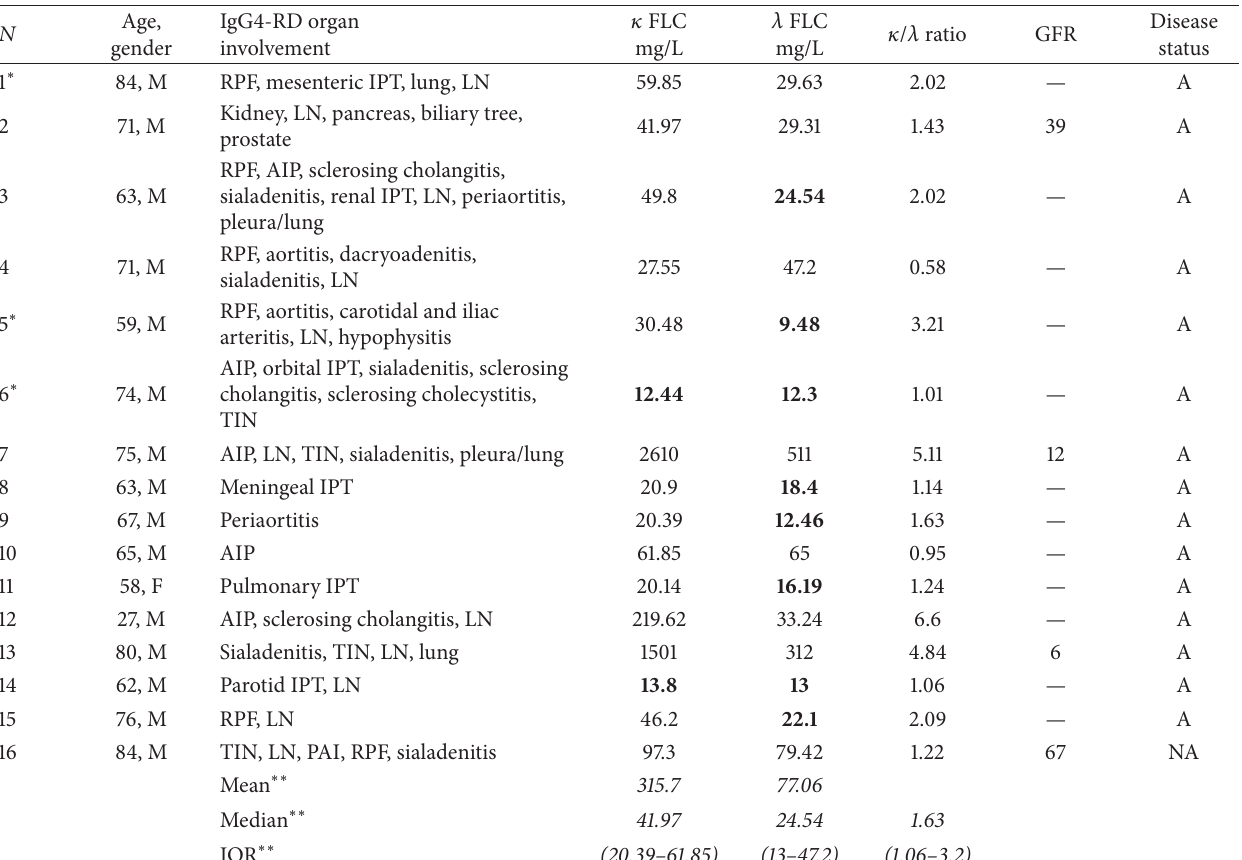
Table 1: Patients’ characteristics.